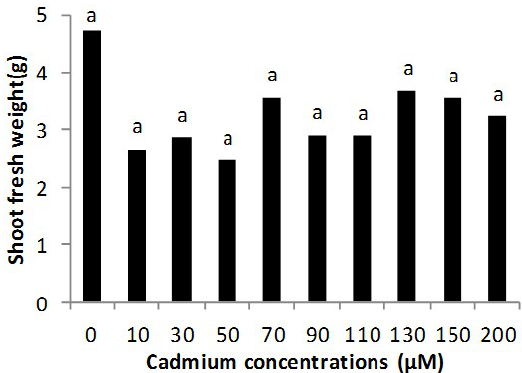
Fig. 3. Effects of cadmium on shoot fresh weight of Brassica napus L.